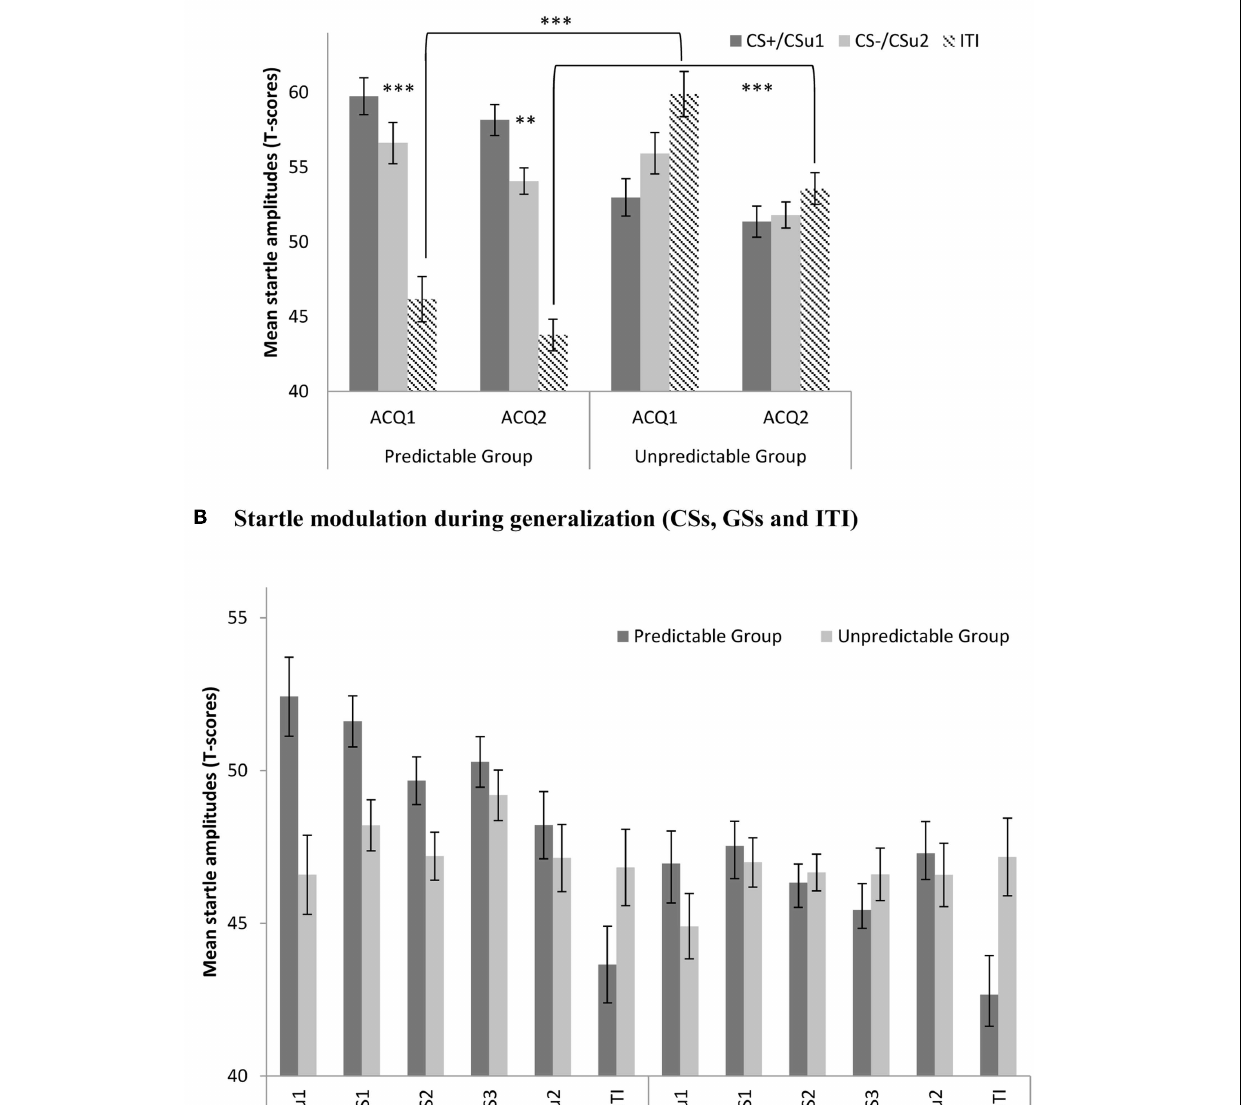
FIGURE 3 | (A) Mean eyeblink startle amplitudes ( + SE’s) during the CS movements and the ITI in the predictable (CS + /CS − ) and the unpredictable group (CS u 1/CS u 2) during the two acquisition blocks (ACQ1-2), and (B) mean eyeblink startle amplitudes ( + SE’s) during the CS movements, the classes of